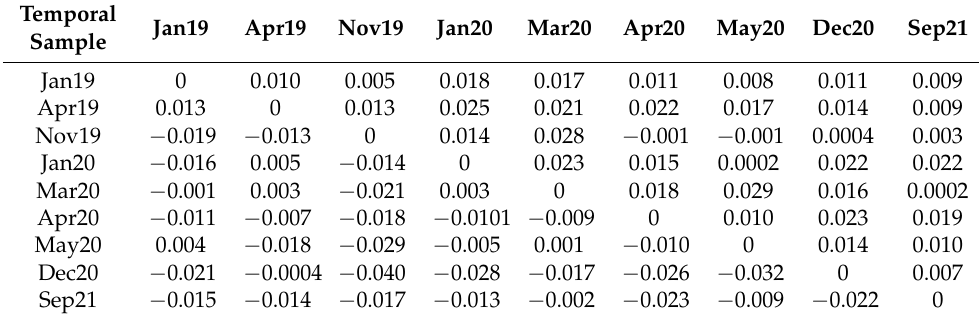
Table 2. Pairwise population matrix of F ST values based on mitochondrial DNA (below diagonal) and microsatellite (above diagonal). None of the pairwise F ST was significant.